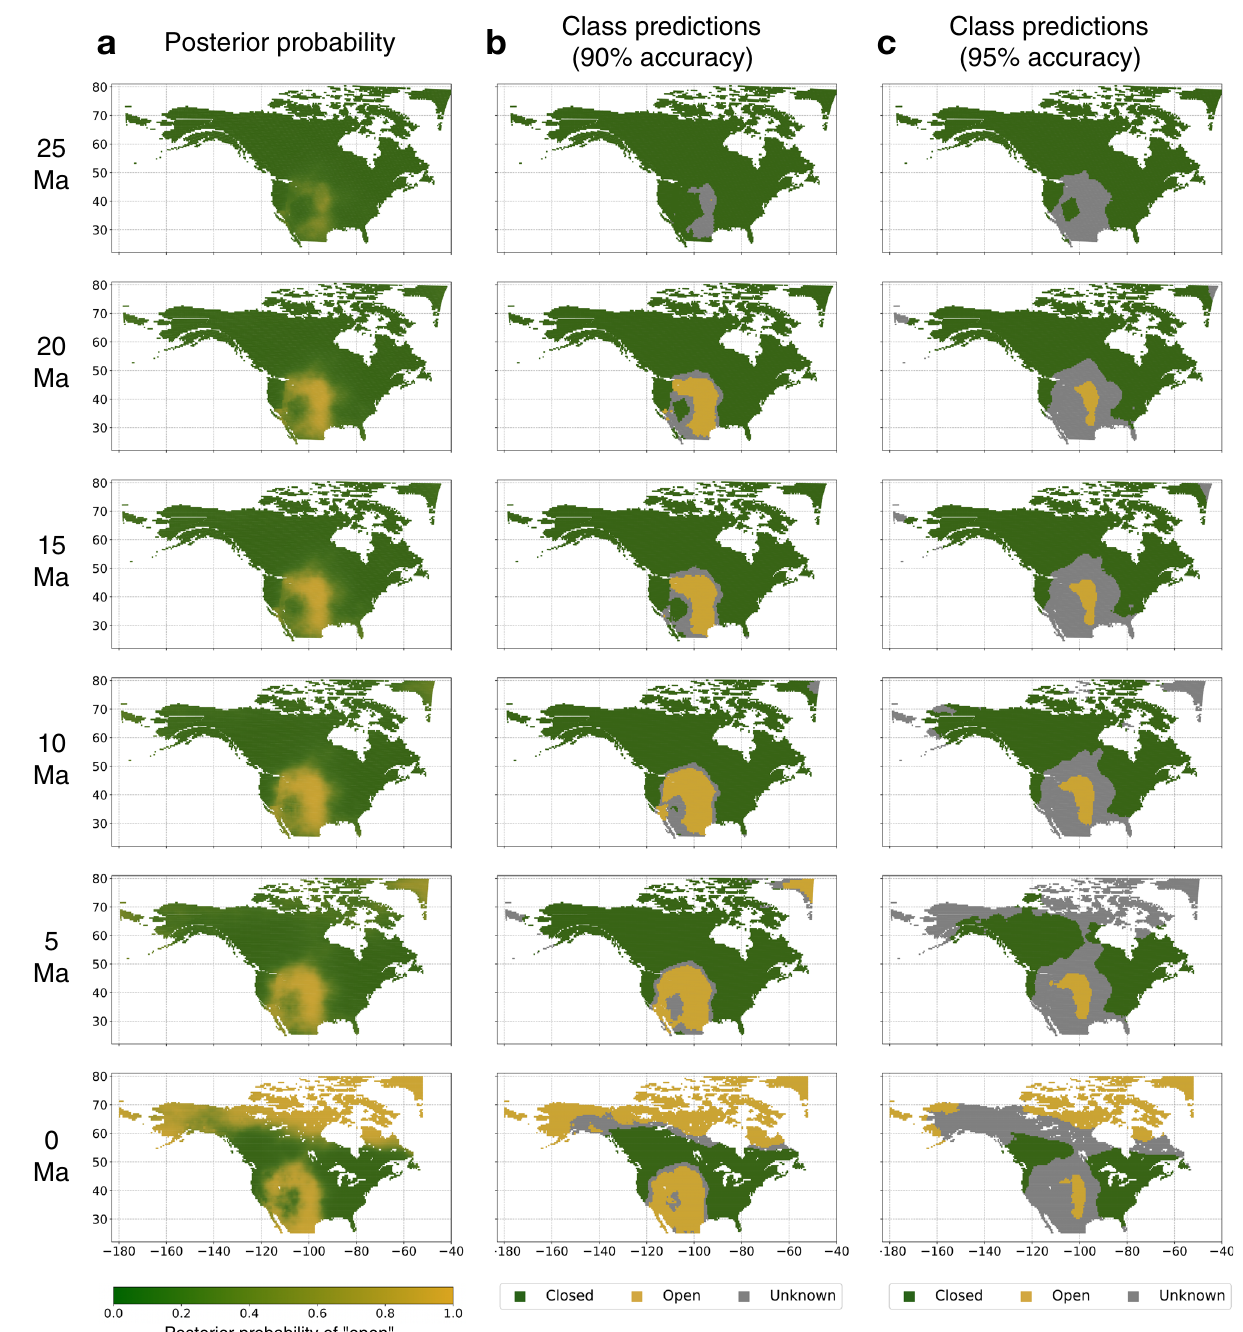
Fig. 3 | Vegetation predictions for North America throughout the last 25Myr. The predictions are based on the best model resulting from our model evaluation and sensitivity tests (model 1, Table 1). Column a shows the posterior probability (PP) estimates for open habitat, where a PP of >0.95 (yellow) indicates strong evidenceforopenhabitat,whereasaPPof<0.05(green)indicatesstrongevidence for closed habitat. Columns b and c show categorical vegetation class predictions